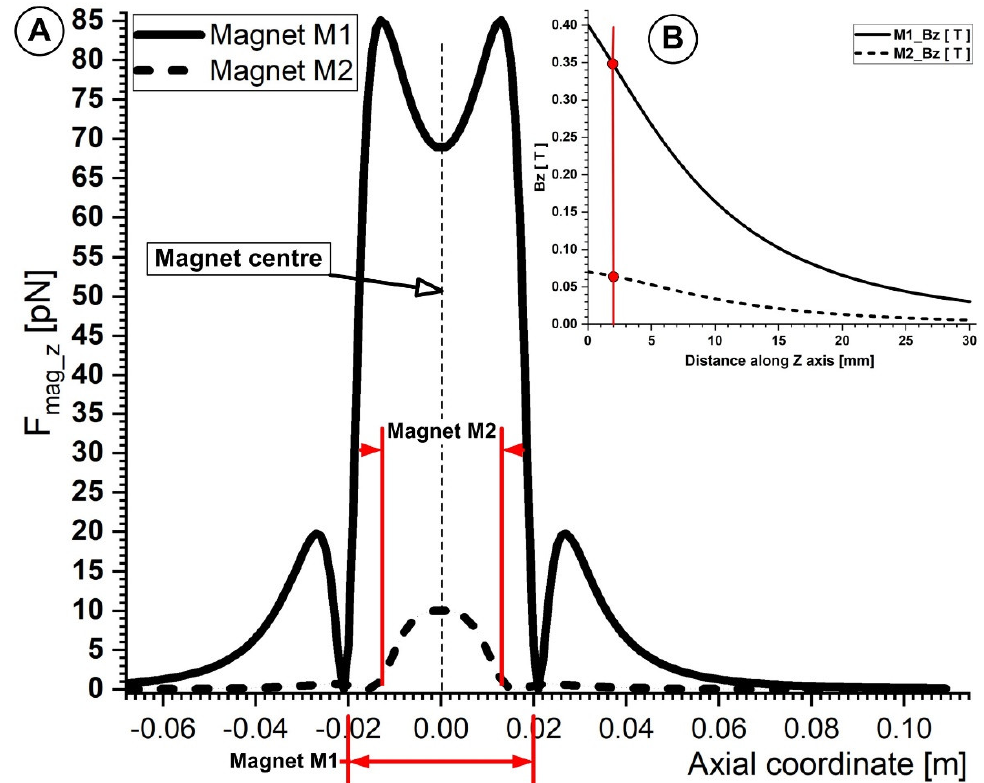
Figure 12. ( A ) Comparison of the magnetic force component F mag_z generated by magnets M1 and M2 along the bottom wall of the vessel. The centers of both magnets are placed in the same position as the vessel bifurcation center. For both magnets that were looked at, the distance between the bottom of the vessel and the magnet surface was h = 2 mm. ( B ) The magnetic field induction B z (T) produced by magnets M1 and M2 are compared along the z axis as a function of the distance to the magnets’ surfaces. Due to the different magnet types (ferrite (M2) and neodymium (M1)) and mag- net grades (Y35 and N52, respectively), there are significant variances between the magnetic field inductions generated by the investigated magnets.